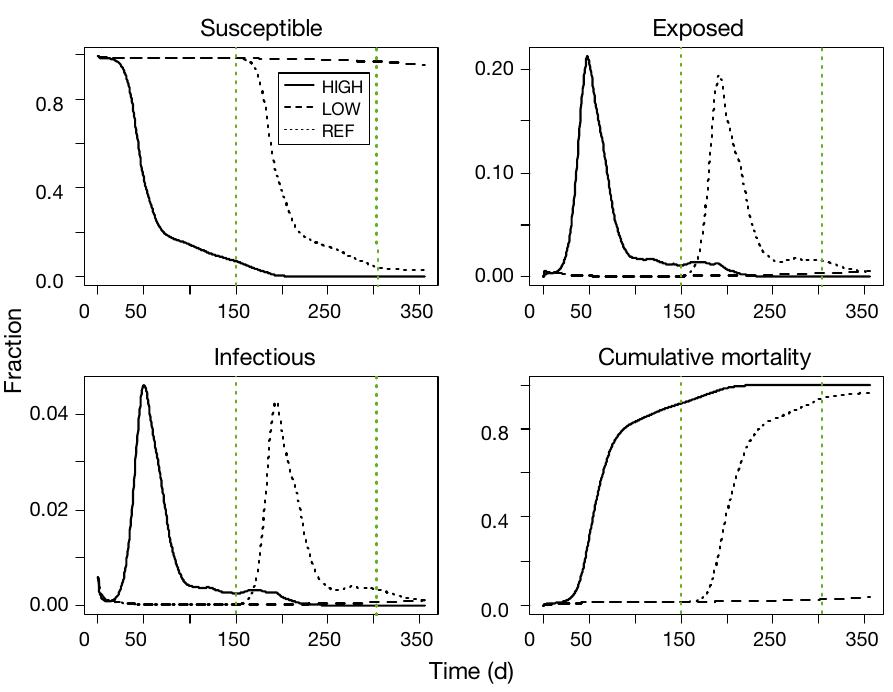
Fig. 7. Dynamics of the epi- demiological states suscepti- ble, exposed, infected, and dead (cumulative mortality) calculated for the whole oys- ter population with 3 temper- ature scenarios (REF, LOW, HIGH) and the same initial infection in patch 78. The green lines show the timing of high/low/high tempera- tures in the REF